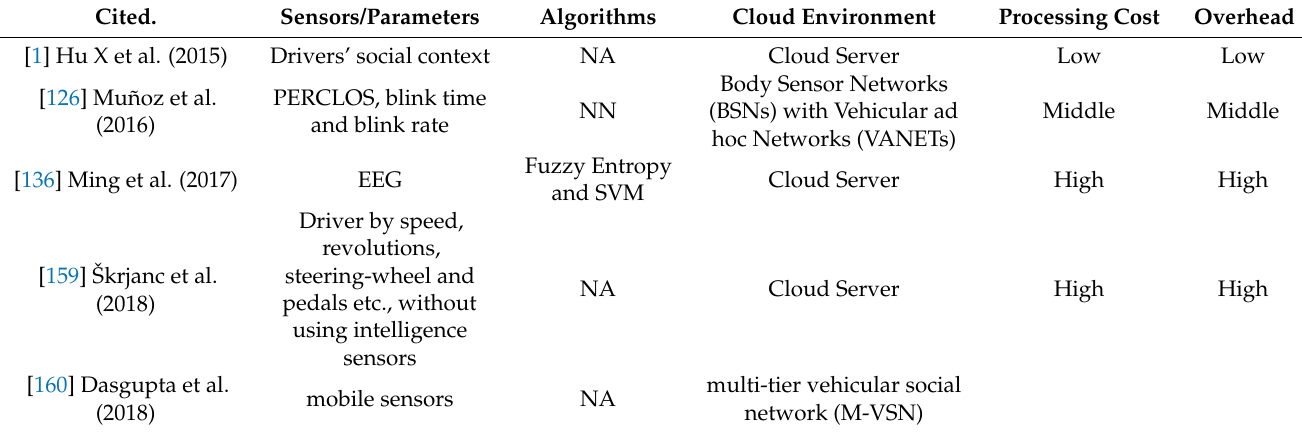
Table 3. Different state–of–the–art DFD systems used IoT–based architecture and machine learning algorithms.